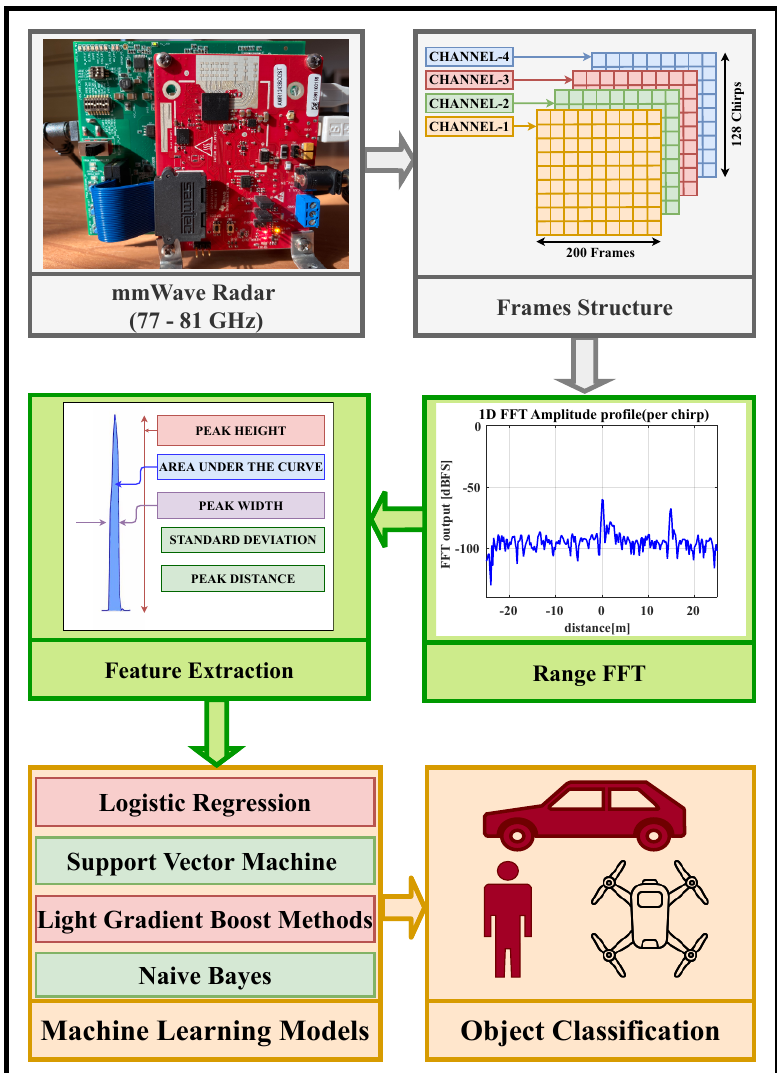
Figure 1. System level